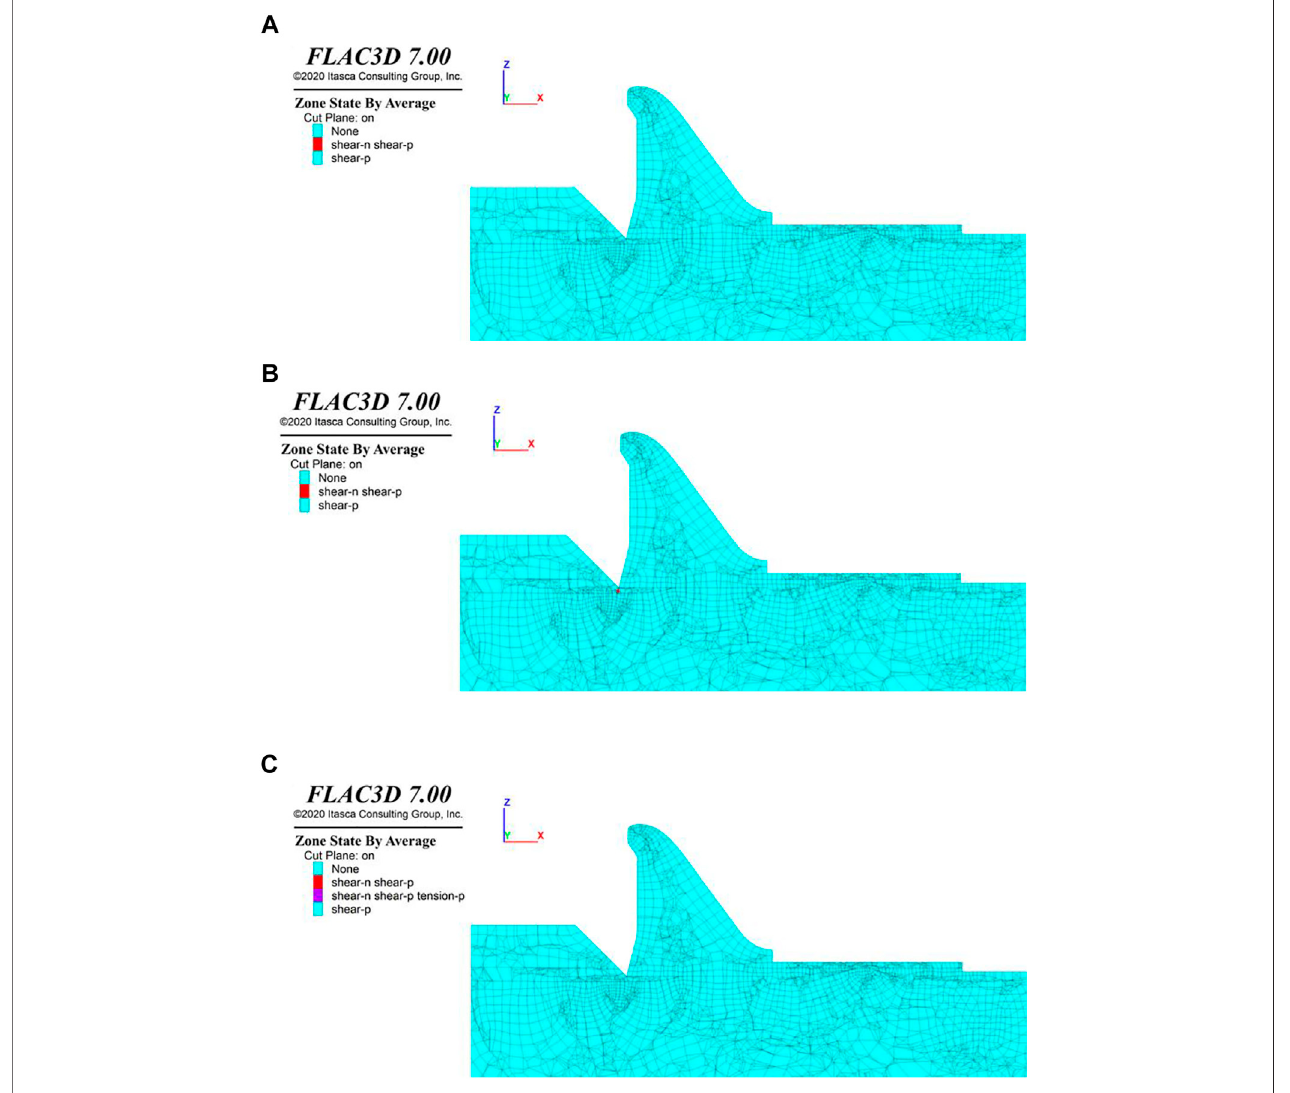
FIGURE 12 | Plastic zones in the pro fi le cutting through the center of dam section 6 under the conditions of (A) SRF = 2.0, (B) SRF = 2.2, and (C) SRF = 2.5.